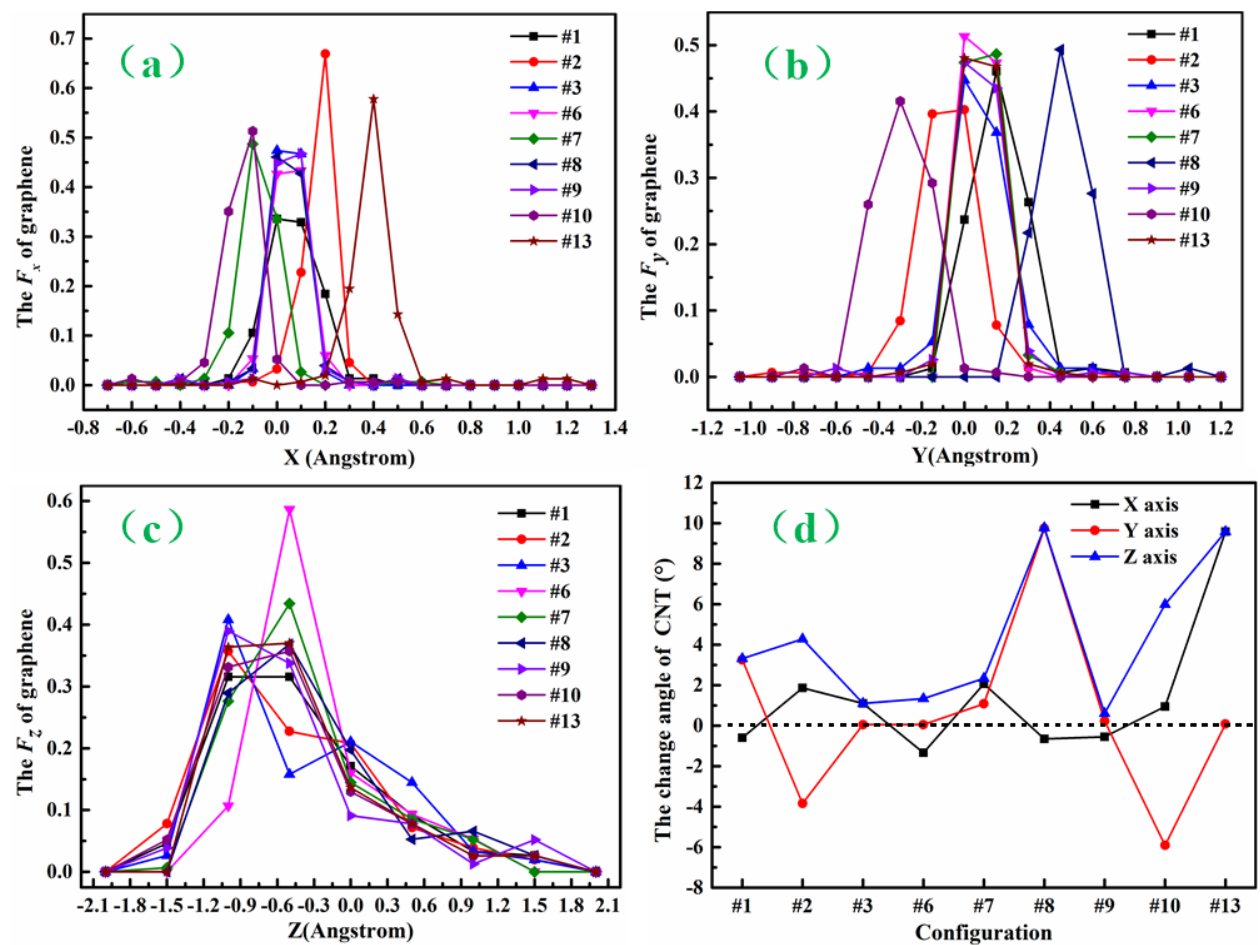
Figure 5. The statistics of position change in the (8,0)CNT-graphene for seamless #1, #2, #3, #6, #7, #8, #9, #10, and #13. ( a ) The f x function broken line; ( b ) The f y function broken line; ( c ) The f z function broken line; ( d ) The change angle of CNT .